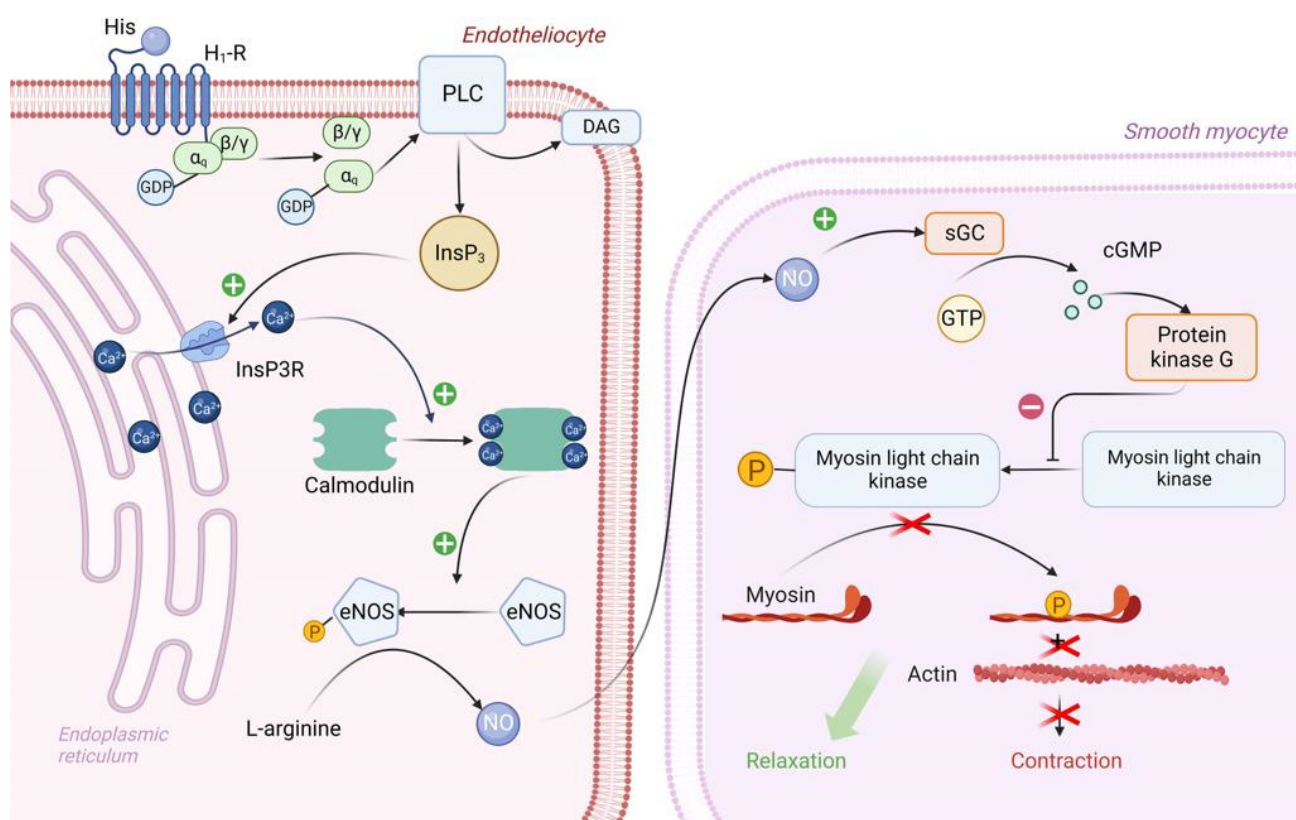
Figure 3. Molecular mechanism of H1 receptor activation by exogenous histamine in SFP. Exogenous histamine binds to the endothelial H1-R and leads to the inositol phosphate pathway activation. InsP3 stimulates Ca release, thereby leading to the Ca/Calmodulin complex formation. Ca/Calmodulin complex activates eNOS, which catalases NO formation. NO enters the sarcoplasm of smooth muscle cells and eventually activates PKG. PKG phosphorylates MLCK, leading to smooth muscle cell relaxation. PLC—Phospholipase C, PIP2—phosphotidylinositol diphosphate,